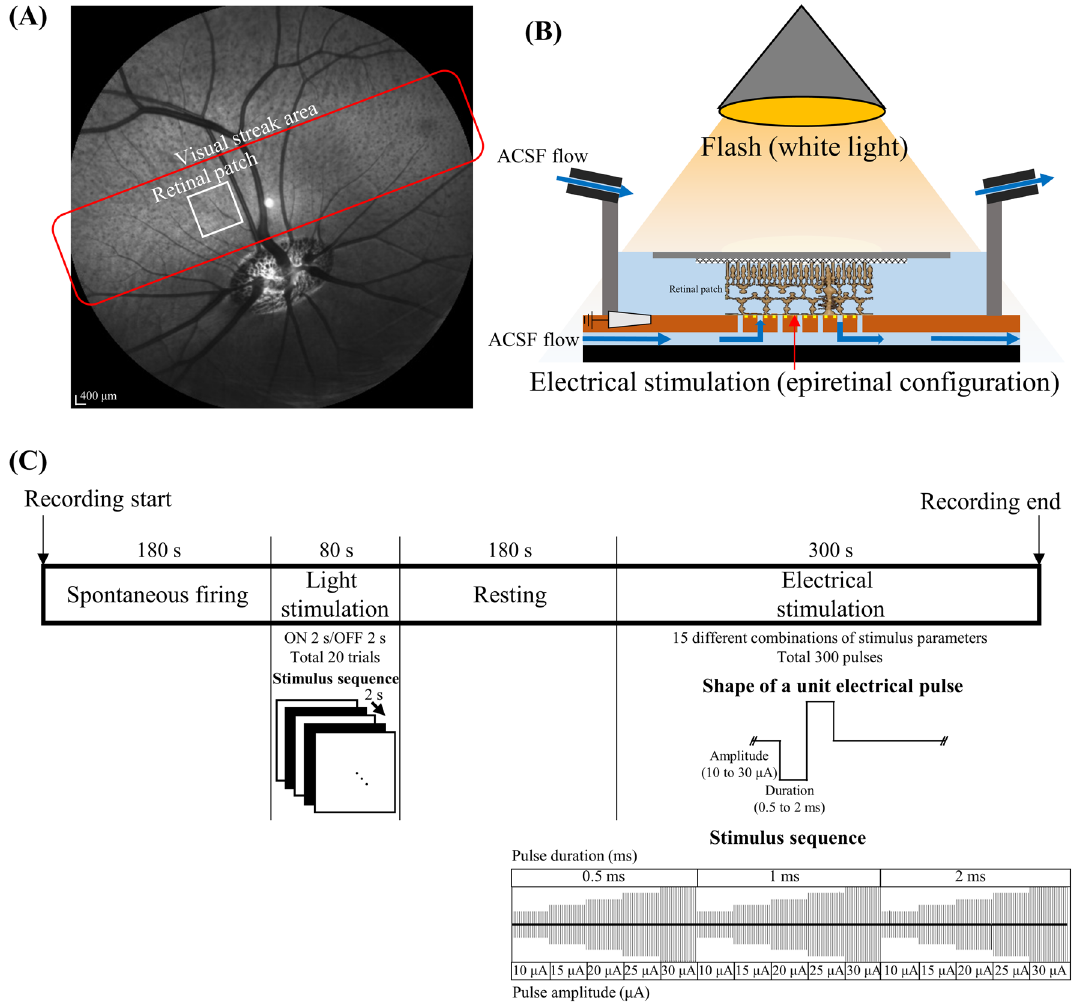
Figure 1. Experimental setup and protocol for in-vitro multi-electrode array (MEA) recording. ( A ) The retinal patch was isolated from the visual streak area. The MEA covers 2 mm × 2 mm of the local area in the entire retina (white box in the visual streak area). ( B ) The isolated retinal patch was mounted on the MEA with the RGC layer facing the electrode array. ( C ) The experimental